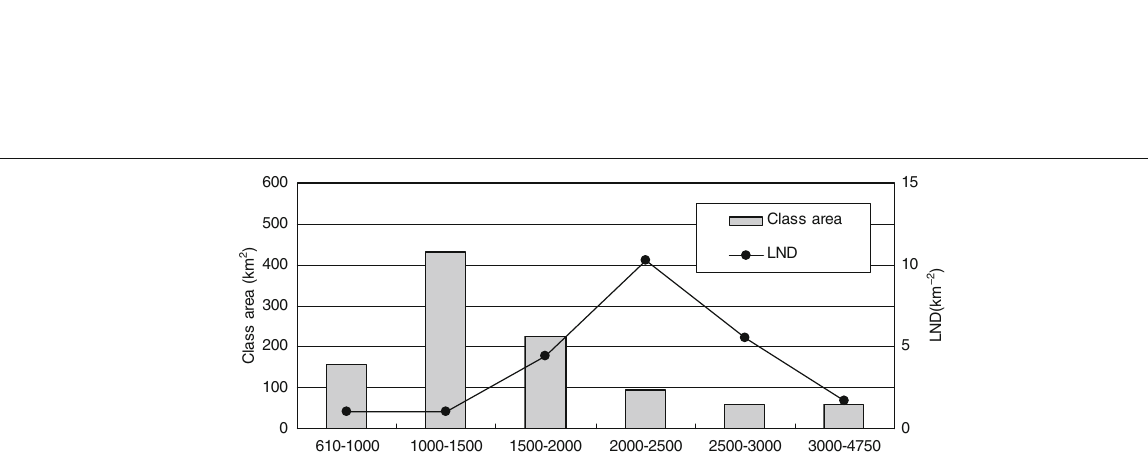
Fig. 10 Relationships between elevation class ( horizontal axis), its area ( vertical axis on left ) and landslide number density (LND, vertical axis on right )